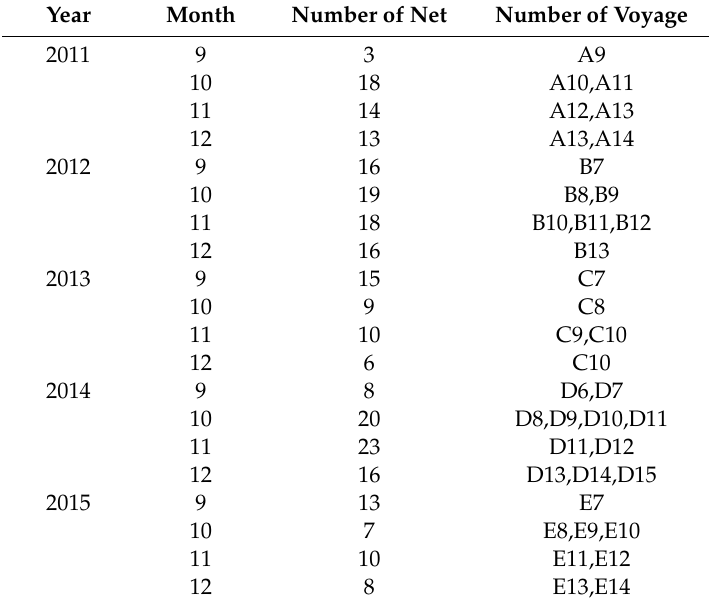
Table 1. Fishing date and number of net and